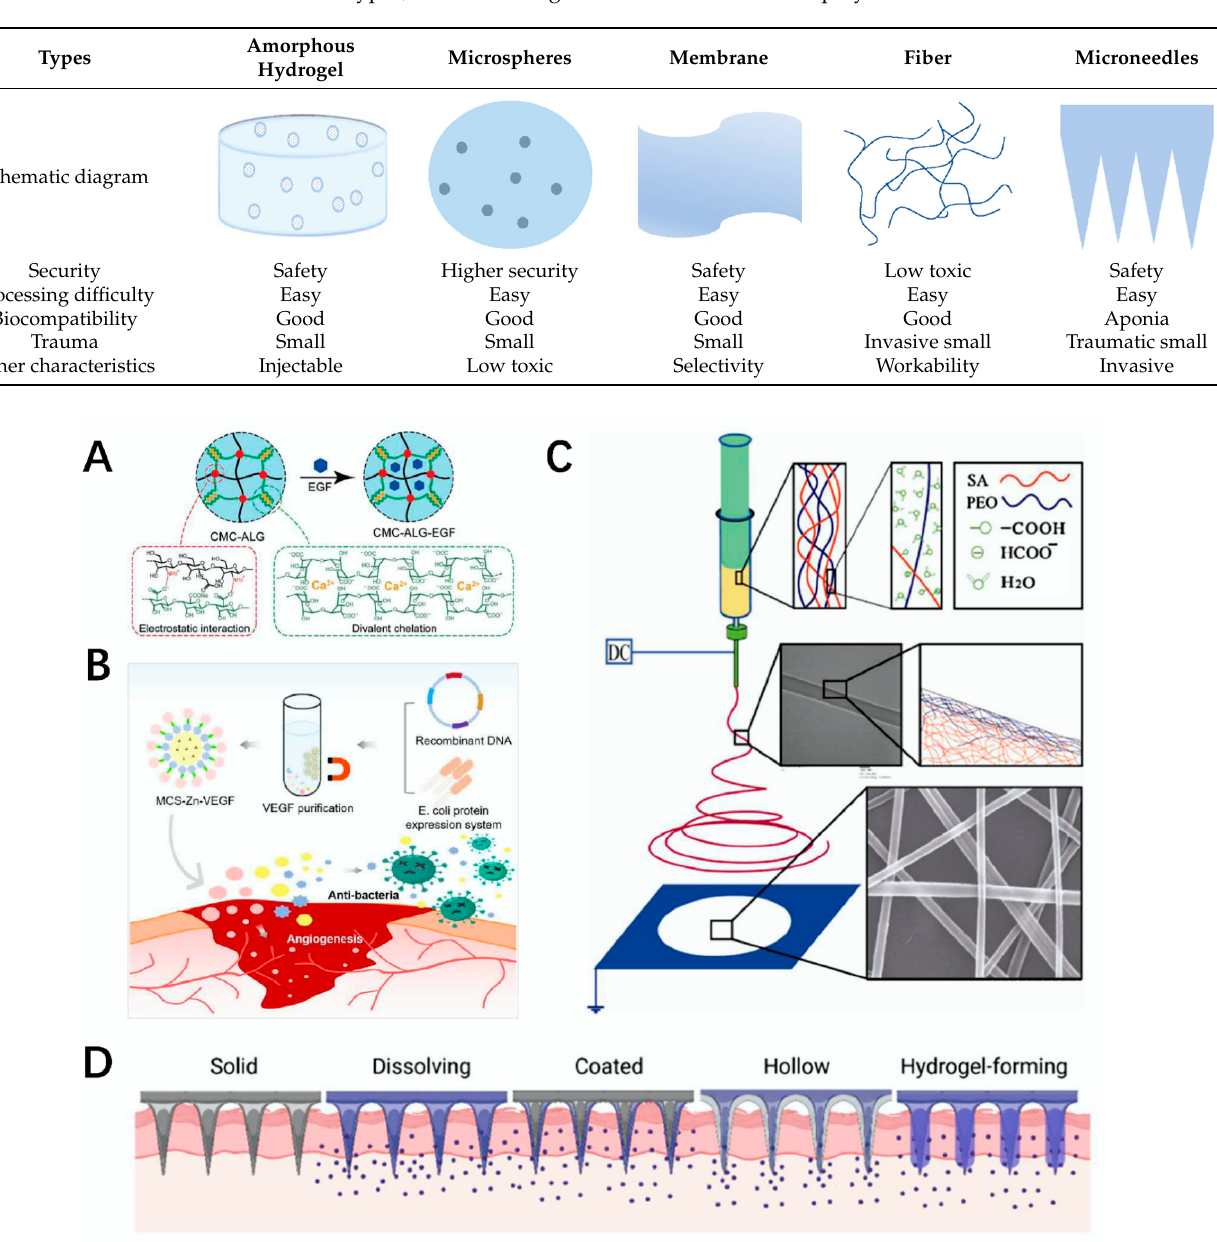
Table 2. Types, schematic diagram and characteristics of polysaccharide derived materials.